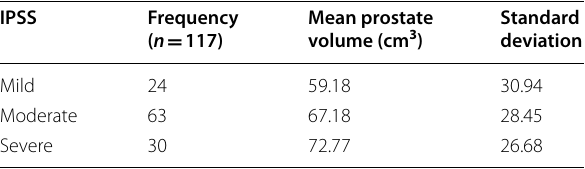
9.825, P value 0.02 = =